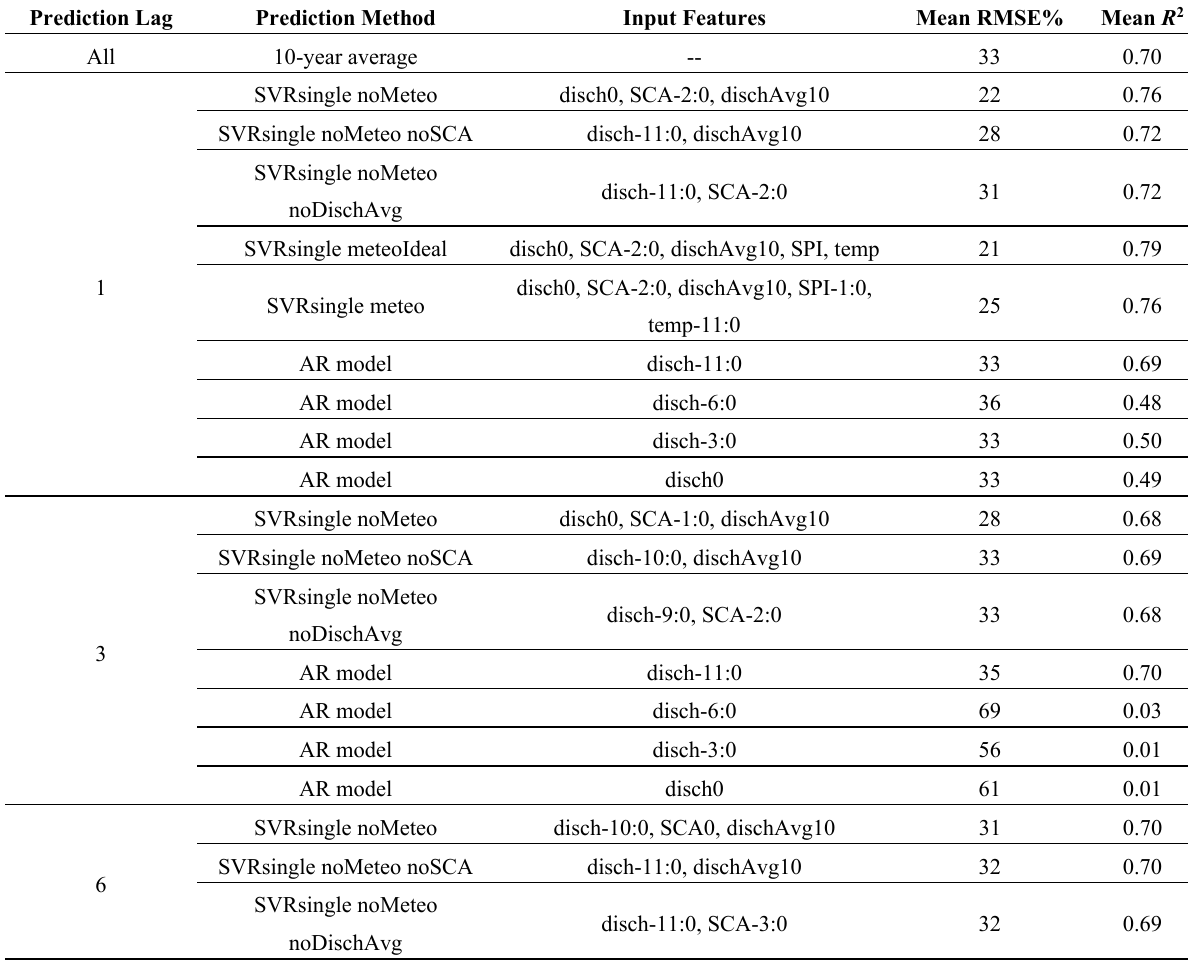
Table 2. Performances of different SVR model configurations for single